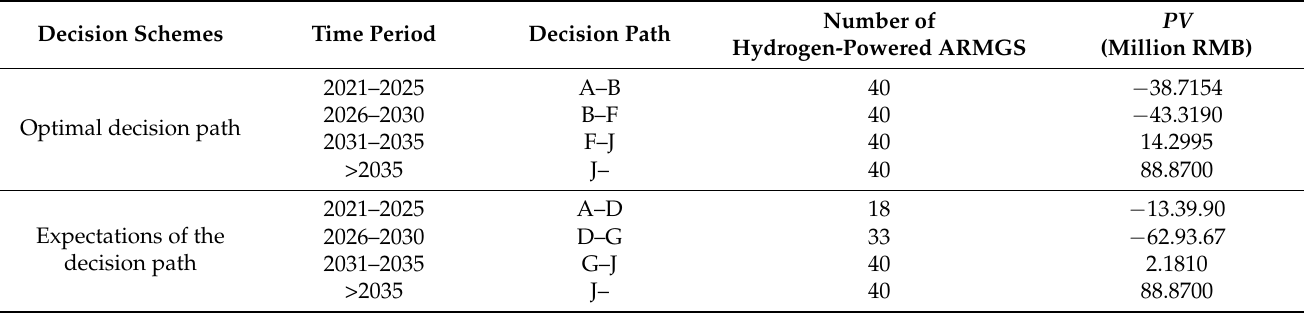
Table 4. Results of low-carbon transition of equipment in Qingdao Port.